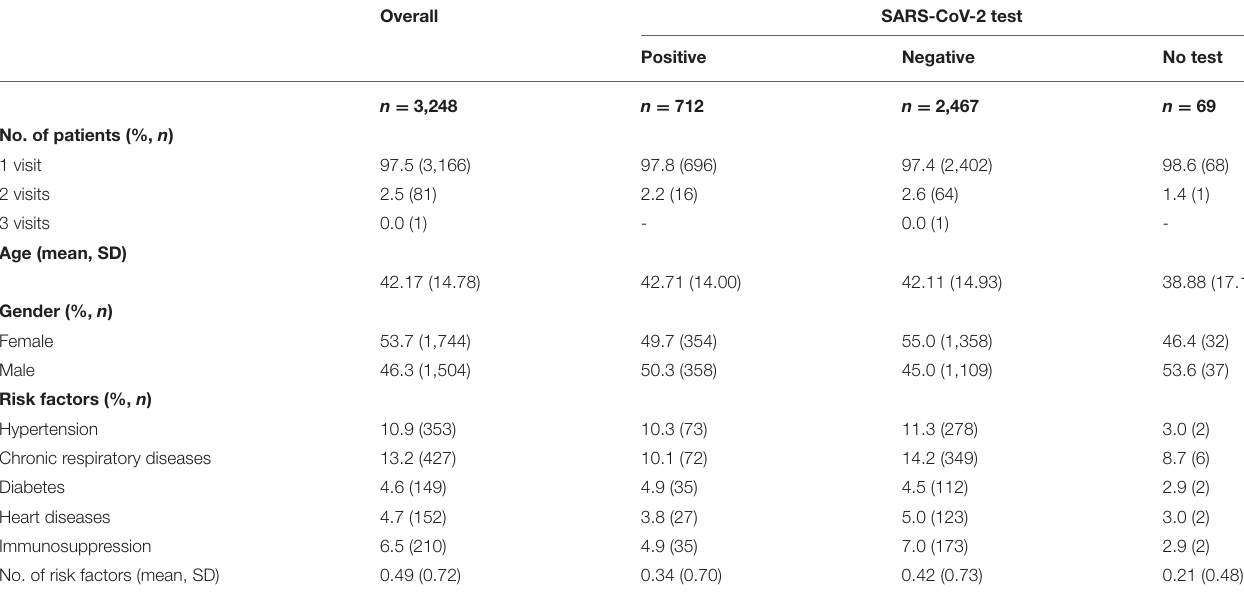
TABLE 1 | Demographics and sample